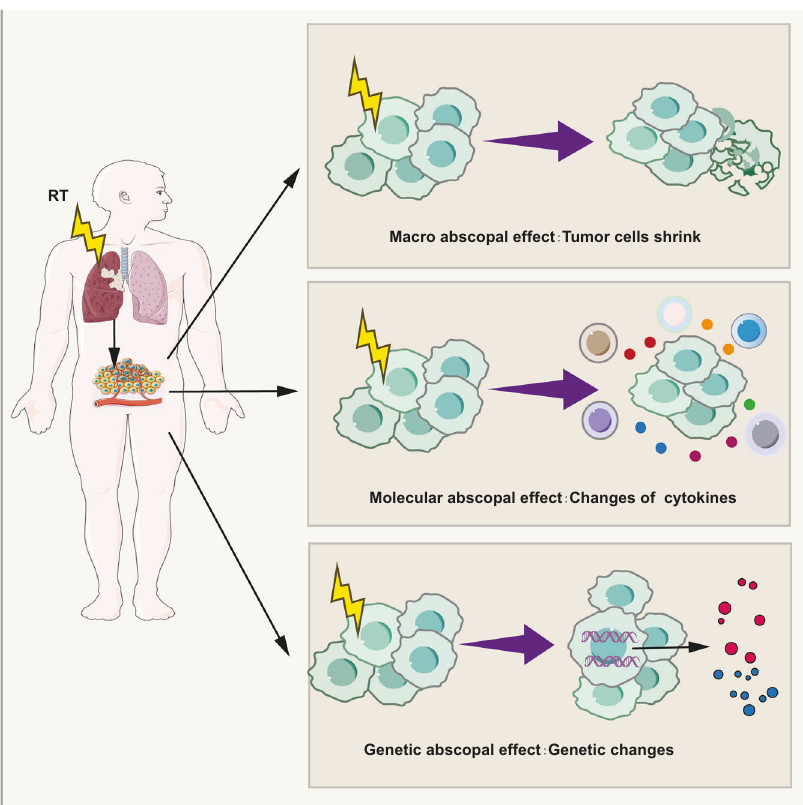
Fig. 9 Macro, molecular, and genetic abscopal effect. Abscopal effect in the traditional sense refers to the tumor regression at distant non- irradiated sites which can be observed in clinic. However, when the primary tumor is irradiated, cytokines and immune cells at distant non- irradiated sites also changes due to the systemic immune response caused by IR. In addition, there are alterations of gene expression at distant non-irradiated sites. Parts of this fi gure were drawn with aid of Servier Medical Art (http://www.servier.com), licensed under a